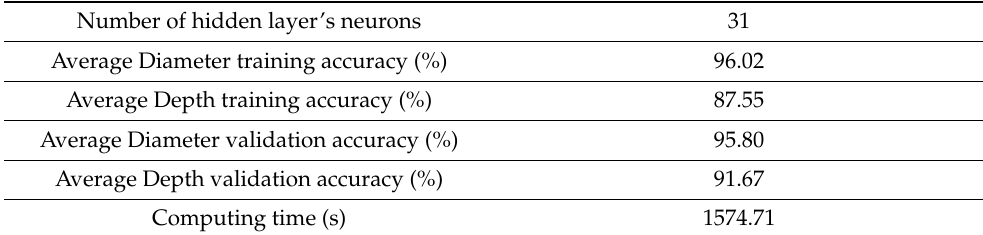
Table 10. Overall statistics of MIMO ANN model.